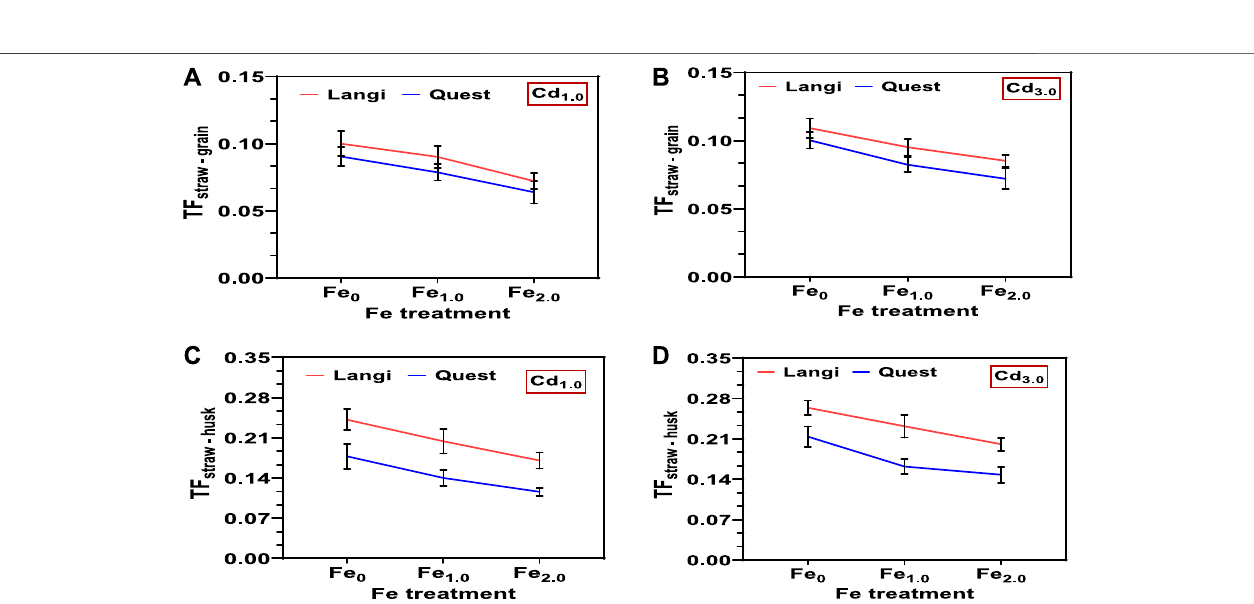
FIGURE 5 | Effect of Fe on translocation factors of Cd from straw to grain (A,B) and straw to husk (C,D) between two Cd levels.